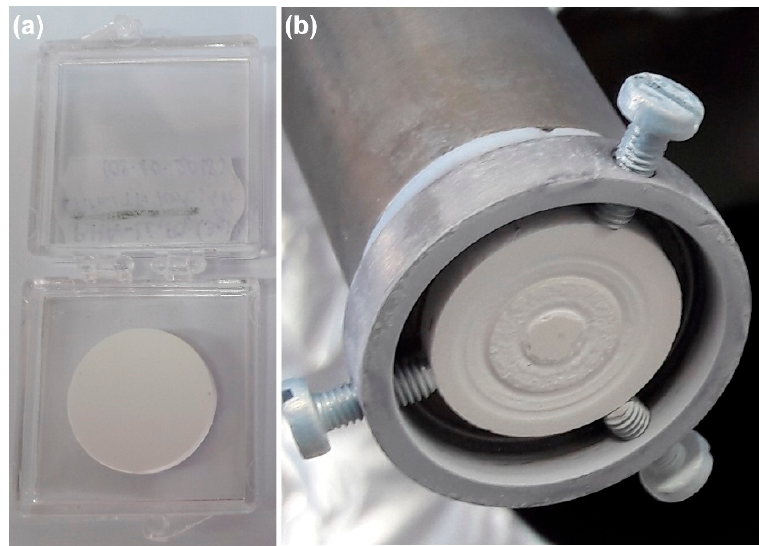
Figure 1. Photos of sintered PLD targets: ( a ) before and ( b ) after the action of the beam generated by a KrF* excimer laser source.